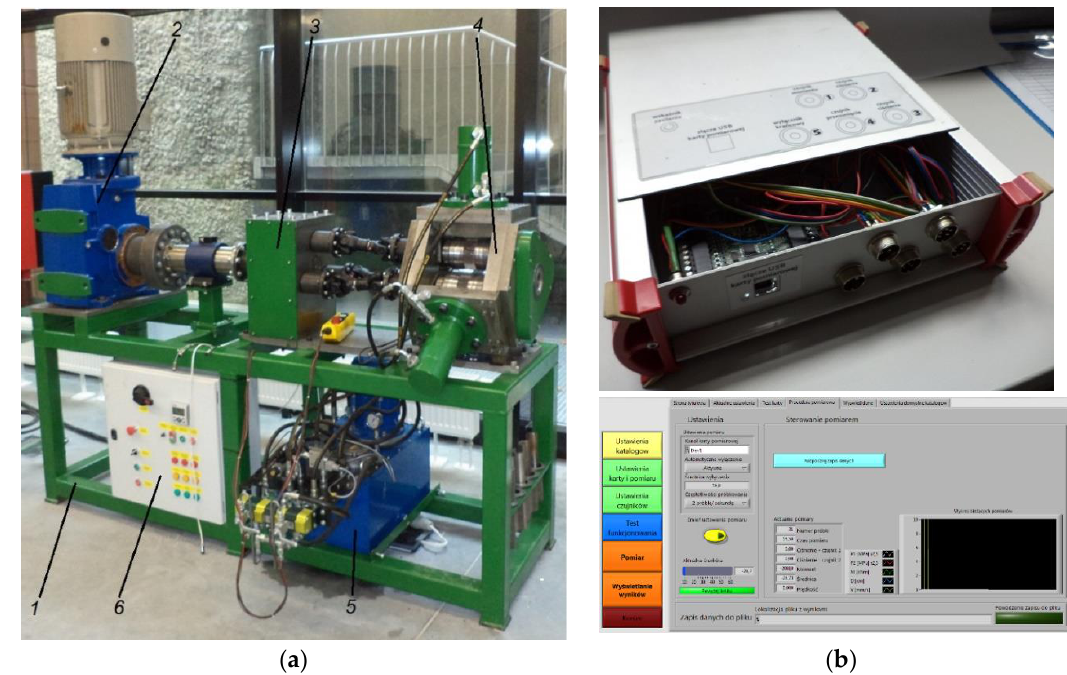
Figure 8. Rotary compression machine for hollow parts: ( a ) view of the machine, ( b ) measuring system with user interface.